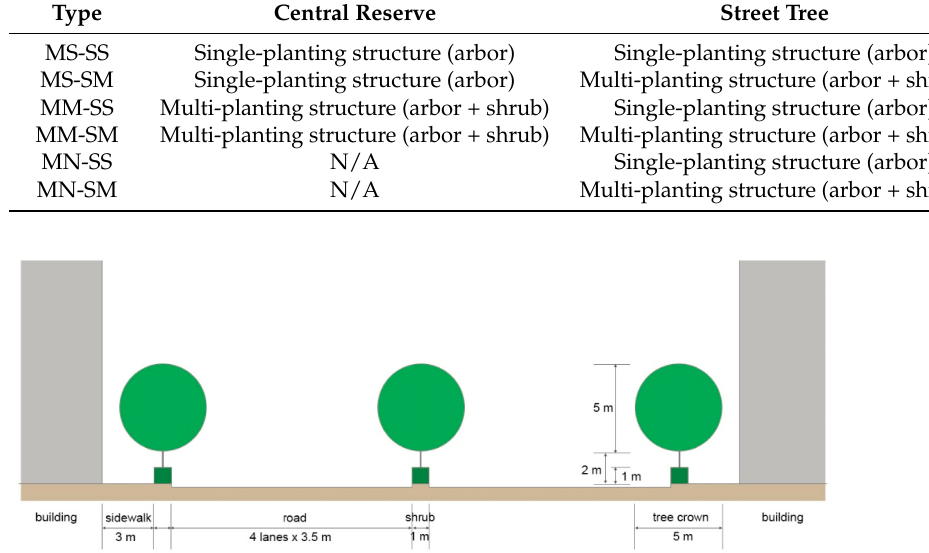
Figure 3. Illustration portraying the cross-section of the structure of the street and the specification of street trees.